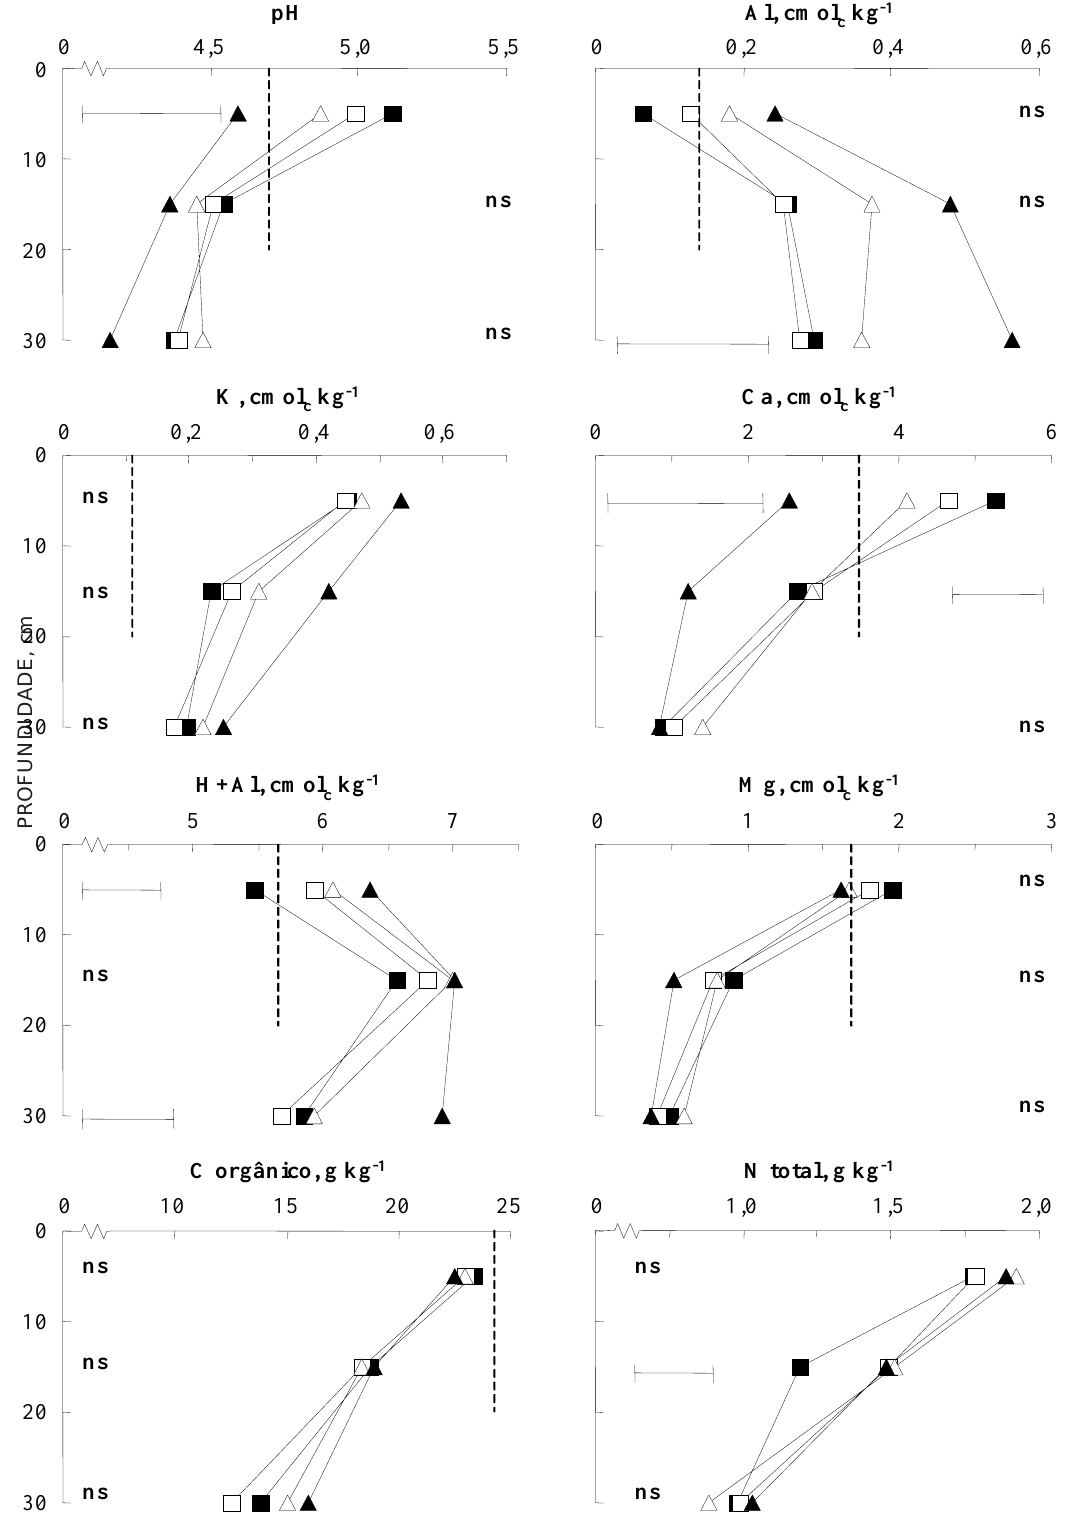
Figura 2. Características químicas do solo em Campo Mourão. Tratamentos: TS ( ); TSA( ); TMA( ); TM( ); Valor Inicial (0-20 cm)( --- ). A seqüência de culturas utilizadas nos sistemas encontra-se no quadro 1. Os valores iniciais não foram considerados na análise estatística. Barras horizontais representam a diferença mínima significativa indicada pelo teste